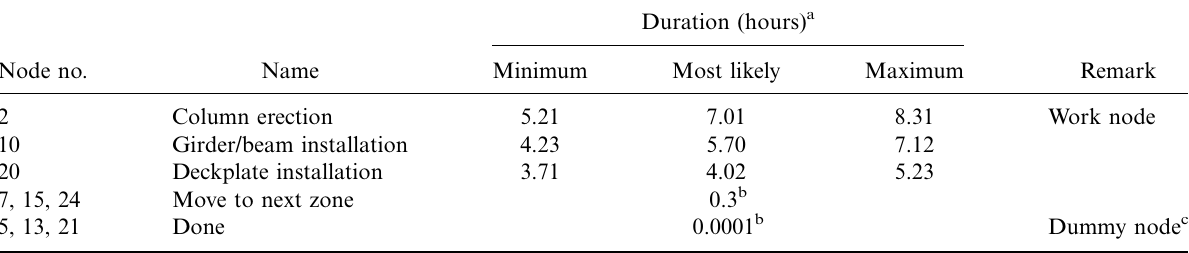
Table 3. Duration input data of case 2 for